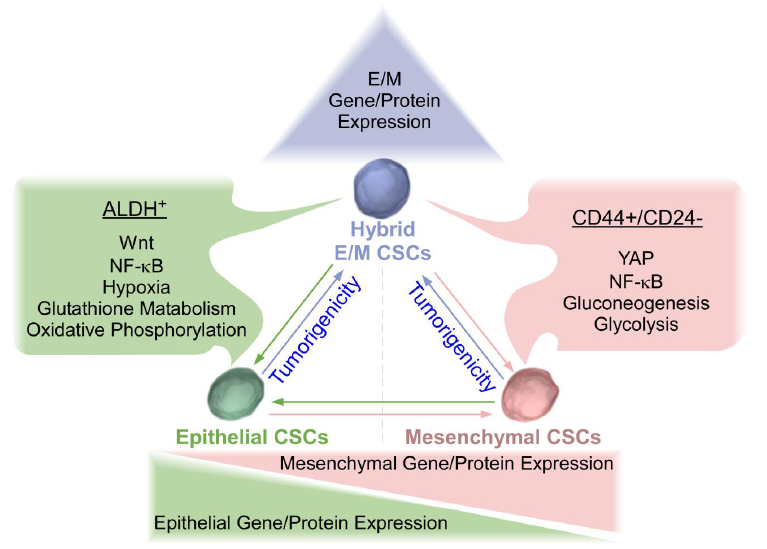
Figure 1. Epithelial, Mesenchymal, and Hybrid triple-negative breast cancer (TNBC) cancer stem cells (CSCs). TNBC mesenchymal (M) CSCs are characterized by CD44 + / CD24 − with elevated levels of Yes associated protein (YAP), nuclear factor kappa-light-chain-enhancer of activated B cells (NF- κ B), and enhanced gluconeogenesis and glycolysis. Conversely, TNBC epithelial (E)